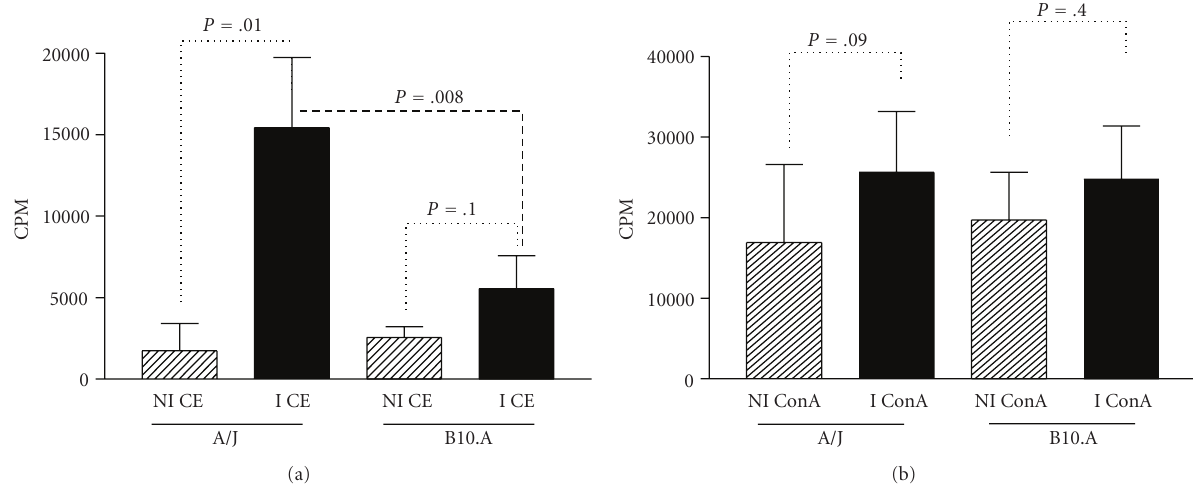
Figure 3: Proliferative response of spleen cells from (a) A/J and (b) B10.A mice immunized with crude extract (CE) of L3 larvae from Lagochilascaris minor stimulated in vitro with ConA or CE. The negative control is the [ 3 H-thymidine] uptake of cells cultivated without stimulation. Bars represent mean values ±